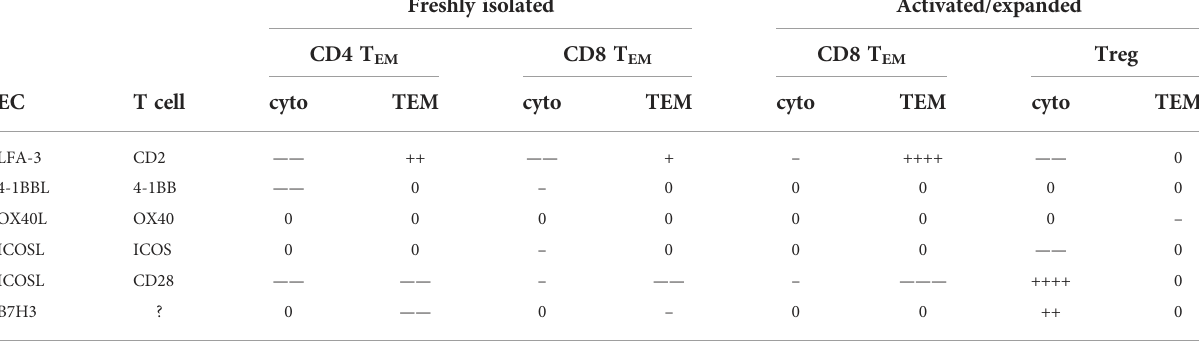
TABLE 1 Summary of costimulatory molecule blocking effects on cytokine expression and TCR-TEM. +, -, 0 denote positive, negative, and no contribution, respectively. The number of symbols refers to signi fi cance as displayed in the fi gures. Freshly isolated